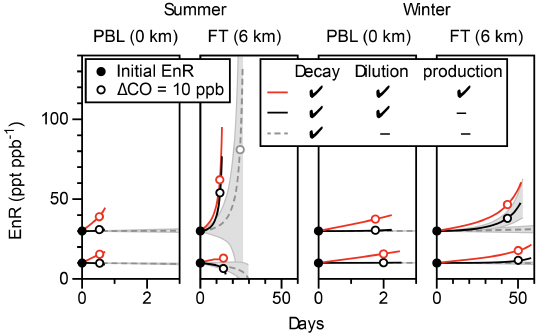
Figure 4. Evolution of acetone–CO enhancement ratios (EnRs) in the mid-latitudinal planetary boundary layer (PBL) and free tropo- sphere (FT) for summer and winter in the Northern Hemisphere calculated numerically (full equation including production term). In the grey dashed lines, only chemical decay of acetone and CO is considered. In the solid black lines dilution is considered in addi- tion. The red lines represent the EnR evolution if acetone is addi- tionally produced by the oxidation of propane. For selected curves, the range of uncertainty is exemplarily shown in light grey colour. The terminating condition for the EnR calculation is a CO enhance- ment of 5ppb. The open circles indicate an CO enhancement of 10ppb. The underlying rates and concentrations are given in Ta- ble